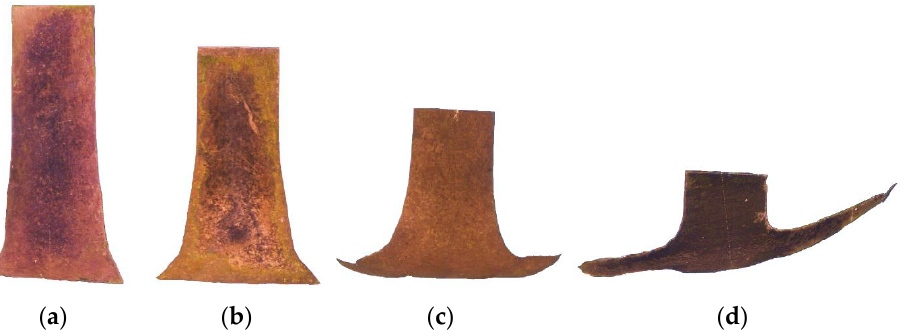
Figure 2. Cross-sections of the copper specimens after impact onto a rigid wall with different initial velocities: ( a ) 162 m/s, ( b ) 225 m/s, ( c ) 316 m/s, and ( d ) 416 m/s. The measured averaged microhardness of the starting copper specimen is 1150 ± 100